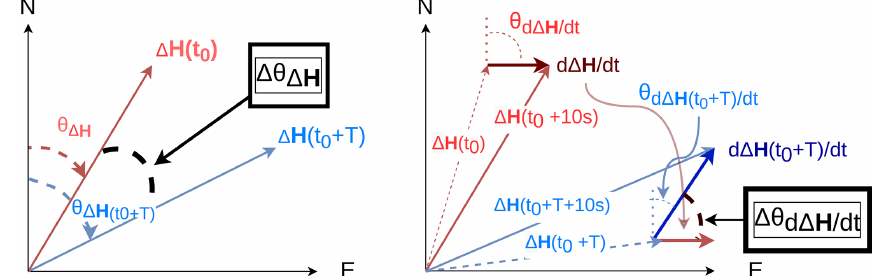
Figure 2. A schematic of the quantity (cid:49)θ for (cid:49) H , and its time derivative, d (cid:49) H / d t , used in this study. (cid:49) H (t) refers to the baseline subtracted magnetic field vector at a specific time, t . θ(t) refers to the angle between (cid:49) H (t) and the geographic north. T is a multiple of the data sampling interval